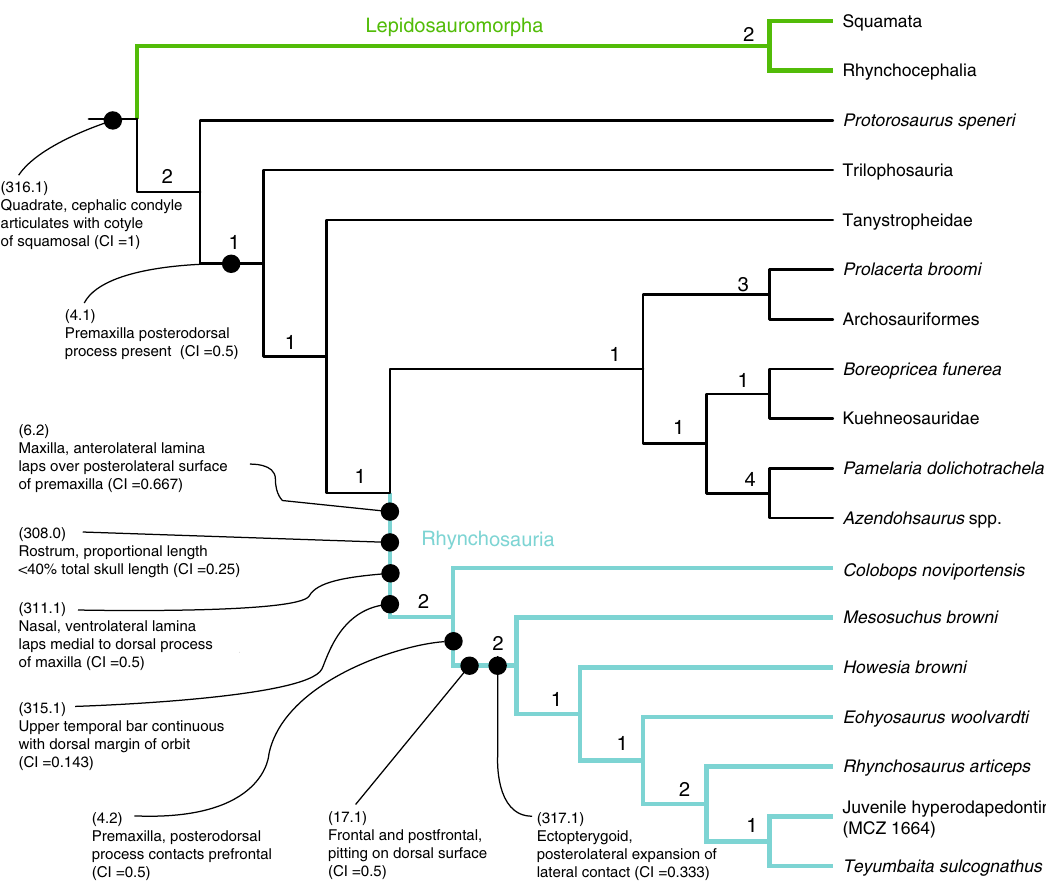
Fig. 5 Phylogenetic af fi nities of Colobops noviportensis . Simpli fi ed strict consensus of most-parsimonious trees based on the species-level parsimony-based phylogenetic analysis of Permo – Triassic diapsids (CI = 0.326, RI = 0.644). Callouts indicate speci fi c unambiguous synapomorphies preserved in YPM VPPU 18835 that support the phylogenetic hypothesis that Colobops noviportensis represents the earliest-diverging lineage in Rhynchosauria. The complete topology of the parsimony analysis is presented in Supplementary Fig. 13, whereas the topology from the Bayesian analysis is presented in